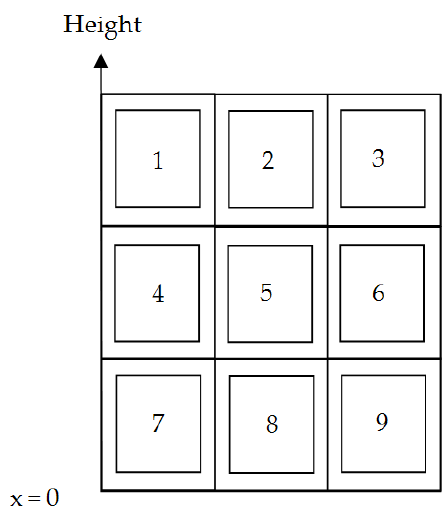
Figure 8. A vertical rectangular wick with nine potential hot spot positions.